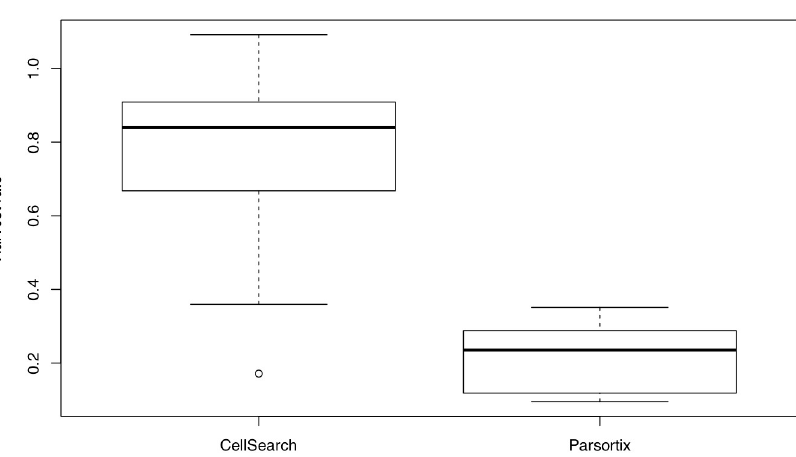
Fig 1. Comparison of mean harvest rates of tumor cells after spike-in experiments in healthy donor blood by Parsortix and CellSearch for both OE33 and OE19. Harvest rates. CellSearch had a harvest rate of 0.76 versus a harvest rate of 0.21 for Parsortix (p <